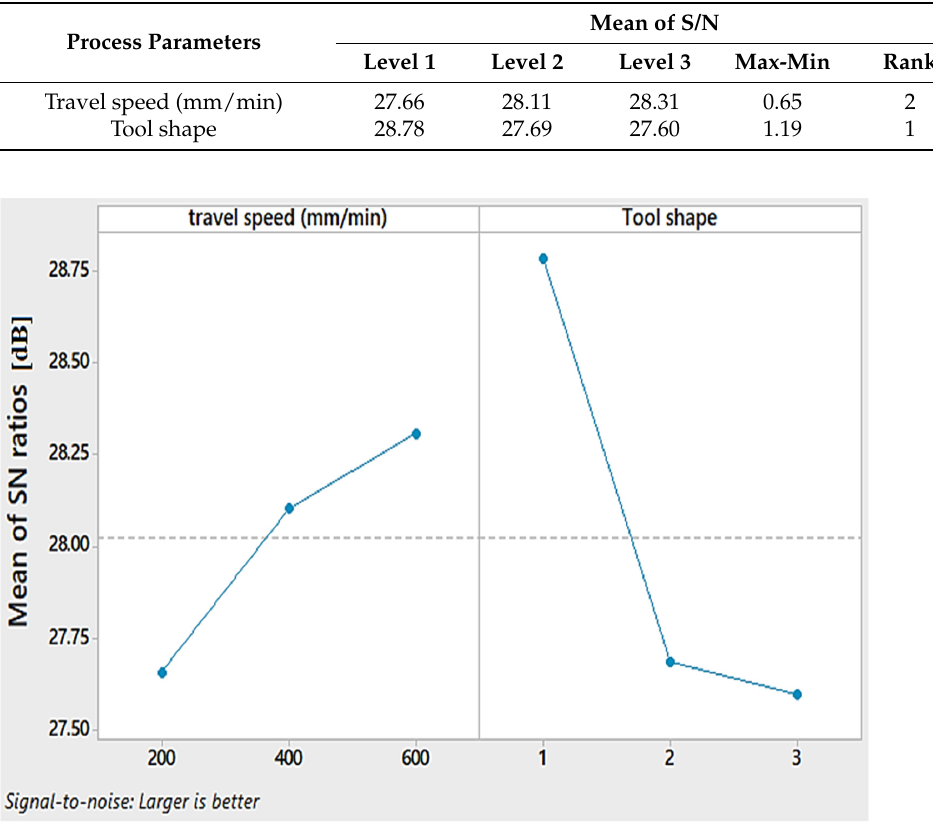
Figure 11. Mean S/N ratio for the hardness of AA1050 thick lap joints.